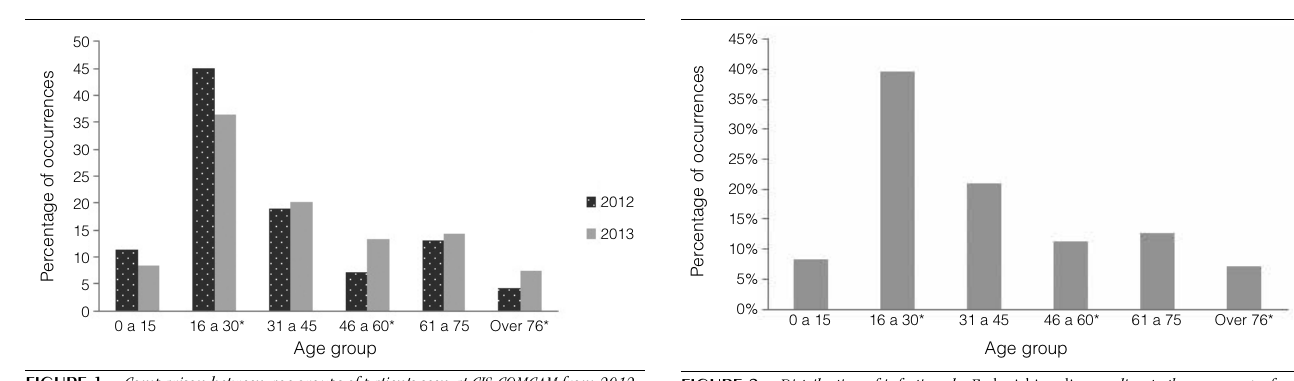
figurE 1 – Comparison between age groups of patients seen at CIS-COMCAM from 2012 to 2013